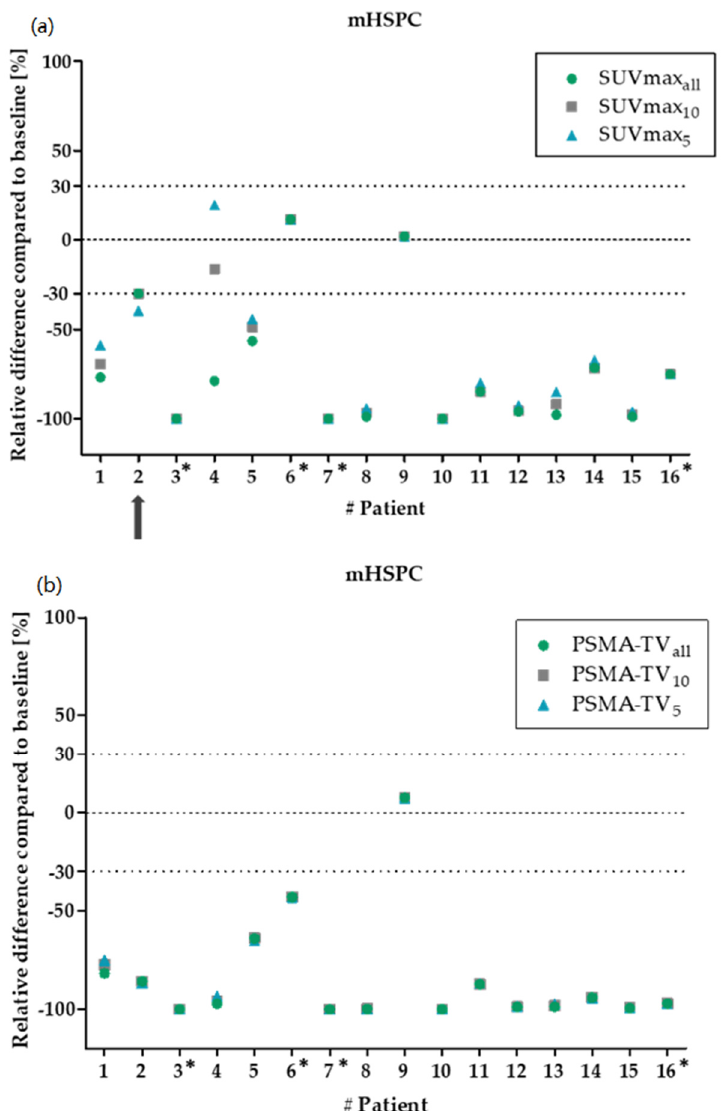
Figure 1. Relative changes between baseline and follow-up for SUV max ( a ) and PSMA-TV ( b ) in patients with metastatic hormone-sensitive prostate cancer (mHSPC). The green dots show the changes for all segmented lesions. The grey squares/blue triangles show the ten/five hottest lesions for SUV max and the ten/five largest lesions for PSMA-TV. The dotted lines mark the borders, which are considered as clinically relevant ( ± 30%). No clinically relevant deviations were found between the segmentation of all lesions and the reduced lesions. The black arrow indicates a clinically non-relevant deviation in one patient for SUV max . The asterisks mark the patients with less than five lesions.